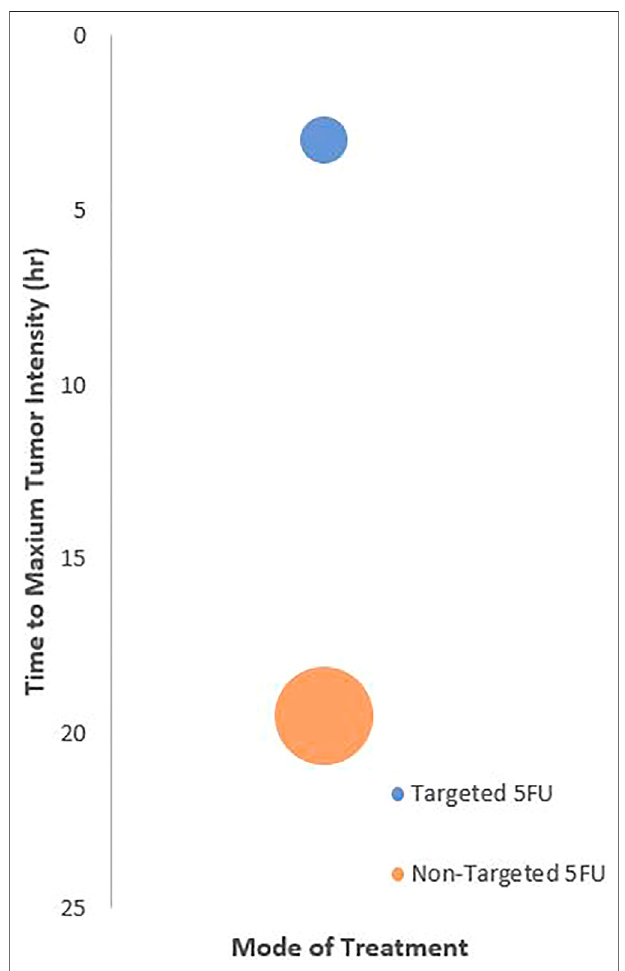
FIGURE 3 | Relationship between treatment targetability and the time to achieve maximum tumor imaging intensity. The center of bubble plot representstheaveragetimeacquiredfromthesamplesofallextractedstudies (n = 4). The radius indicates standard deviation time.